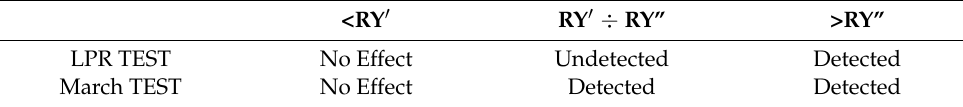
Table 3. Effectiveness of the different test methods with respect to the R2 defect.